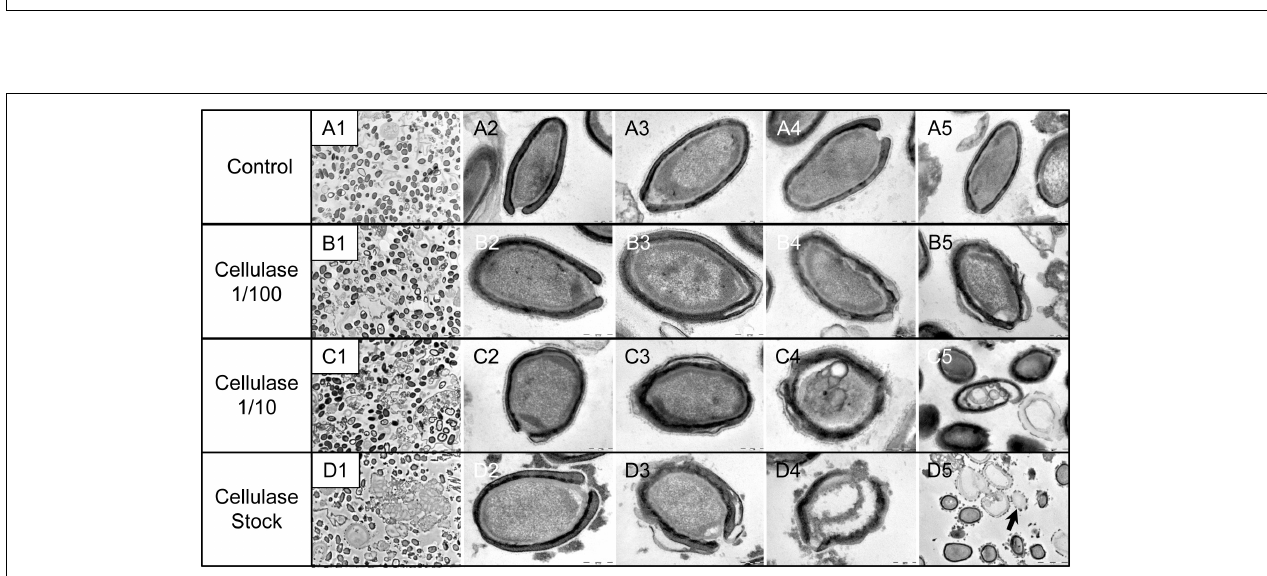
FIGURE 8 | Confocal imaging of Calcofluor-stained cellulase-treated P. massiliensis virions and scanning microscopy of cellulose treated P. massiliensis . (A1) Control condition with untreated P. massiliensis particles stained with Calcofluor-white. (B1,C1,D1) Cellulase-treated P. massiliensis particles stained with Calcofluor-white. (A2,A3) Control condition with untreated P. massiliensis . (B2,B3,C2,C3,D2,D3) Cellulase-treated P. massiliensis particles imaged with scanning microscopy on two magnification.